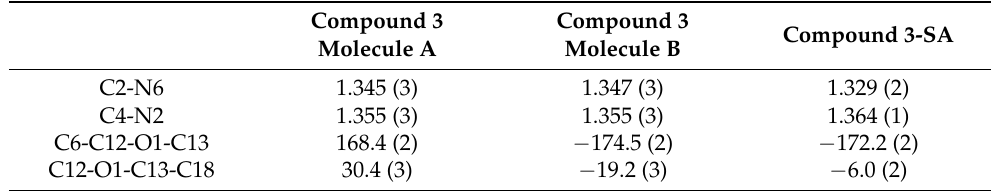
Table 7. The comparison of selected bond lengths [Å] and torsion angles [ ◦ ] in compounds 3 and 3-SA